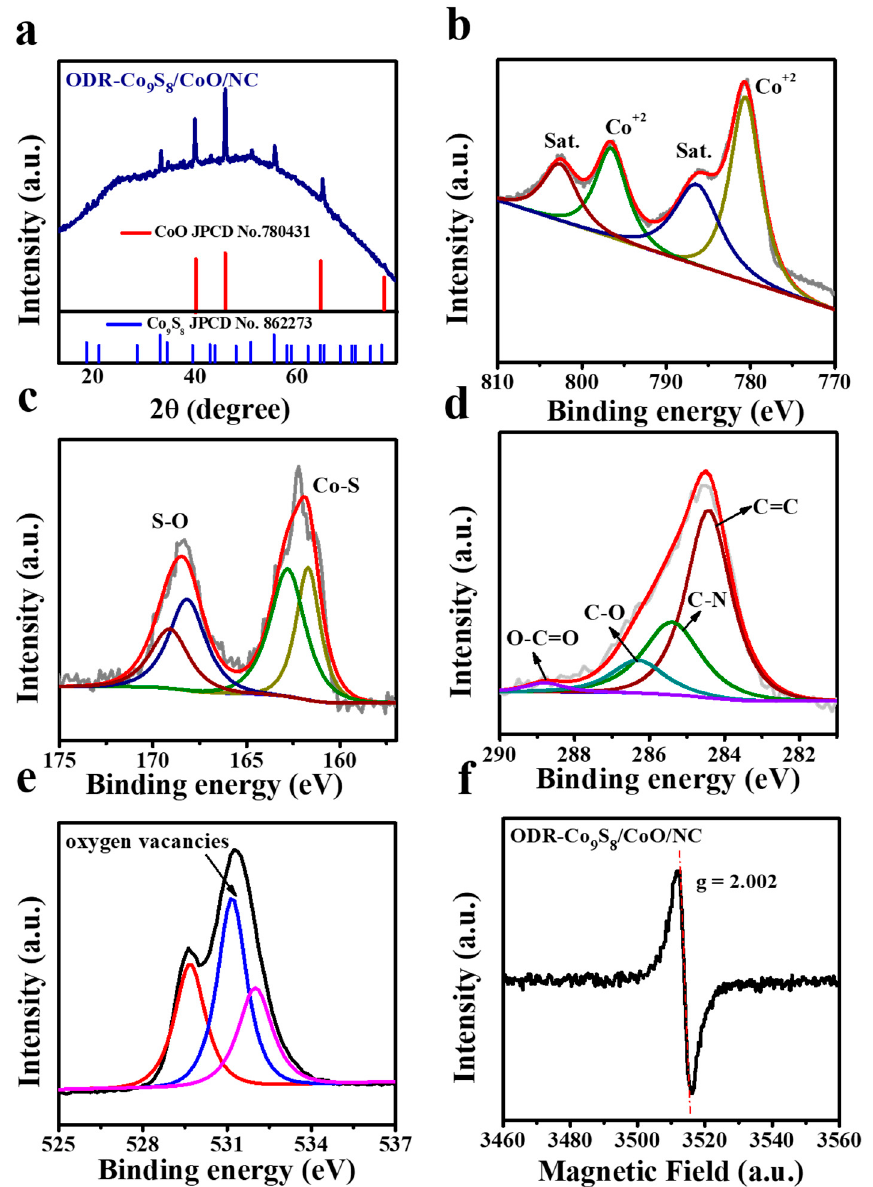
Figure 3. ( a ) XRD signals for ODR-Co 9 S 8 /CoO/NC heterostructures; ( b – e ) Core-level spectra of Co 2p, S 2p, C 1s, and O 1s elements of ODR-Co 9 S 8 /CoO/NC heterostructures; ( f ) EPR for ODR- Co 9 S 8 /CoO/NC.